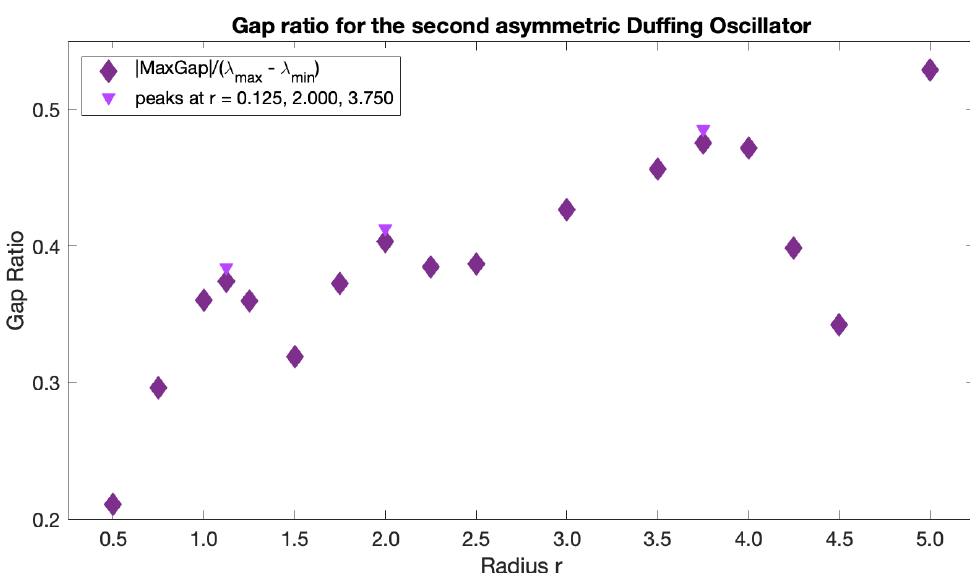
Figure A8. Step 1 of the spectral clustering protocol for the asymmetric Duffing oscillator shown in Figure A7: sweep of r parameters with offset coefficient 10 7 for the average distance